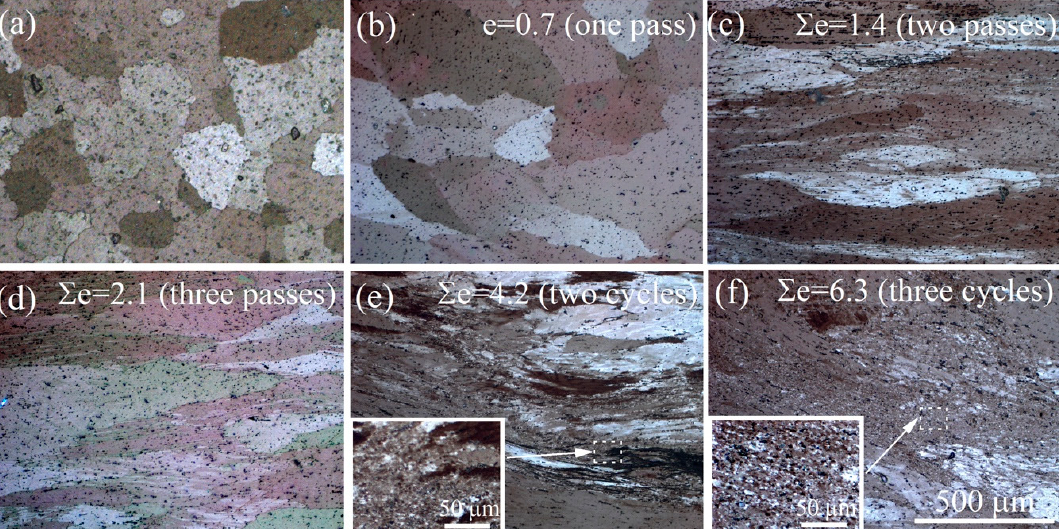
Figure 3. Evolution of the grain structure in the near-surface layer during isothermal multidirectional forging at 350 °C: ( a ) as-cast structure; ( b ) the first pass along the z-axis; ( c ) the second pass along the y-axis; ( d ) the third pass along the x-axis; ( e ) two cycles with ∑ e = 4.2; ( f ) three cycles with ∑ e = 6.3; inserts in the ( e ) and ( f ) grain structures of the local places at a higher magnification; polarized light, optical microscope.